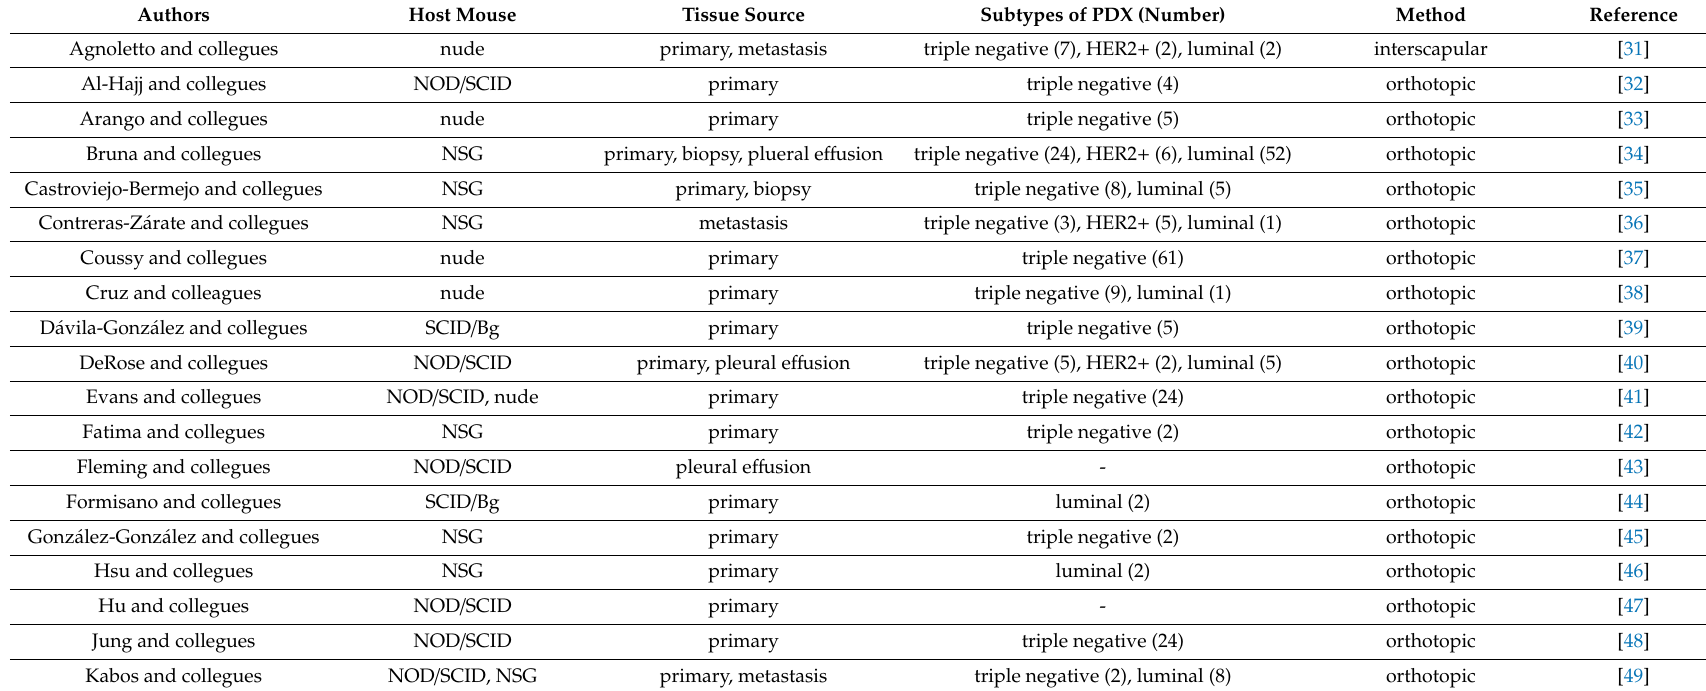
Table 2. Applications of each breast cancer subtype patient-derived xenograft